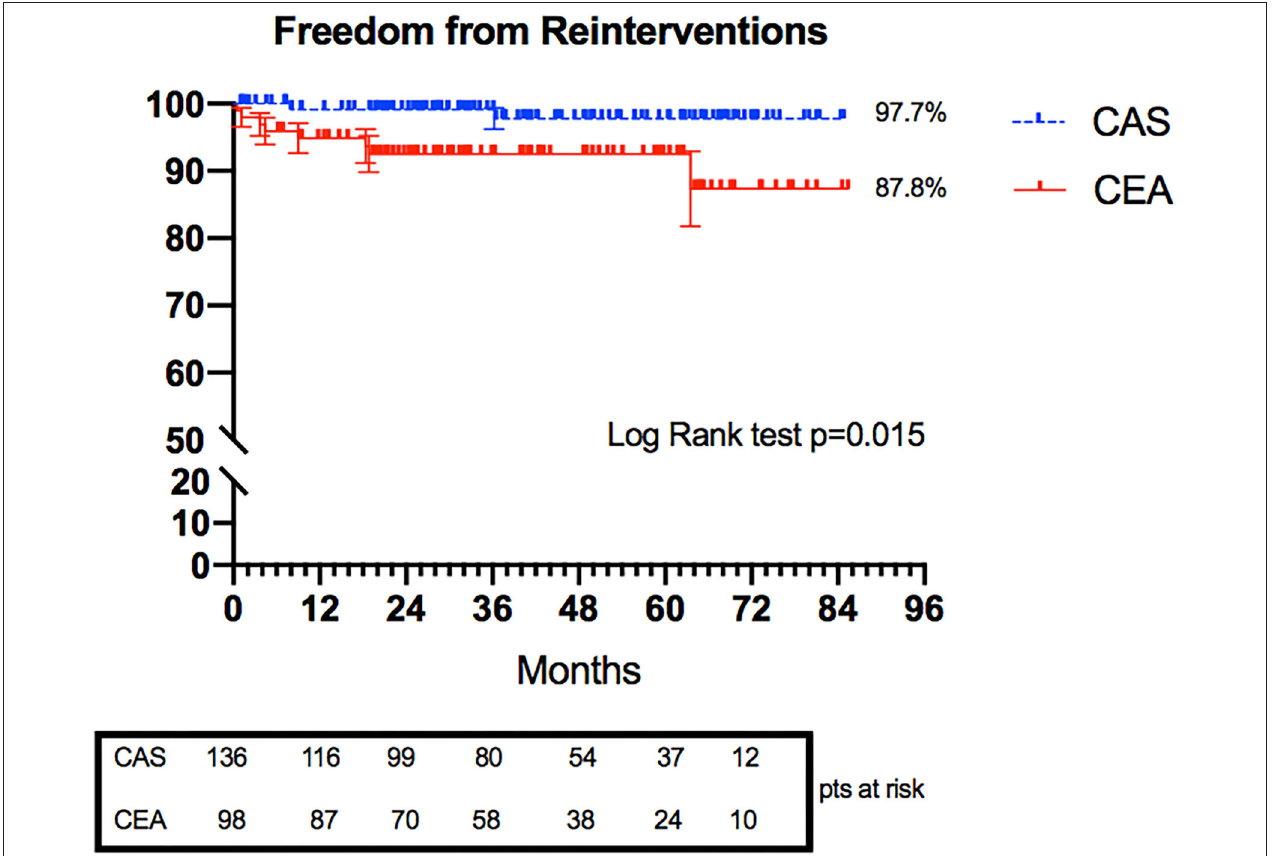
FIGURE 4 | Kaplan–Meier curves representing freedom from reinterventions in CAS and CEA groups.